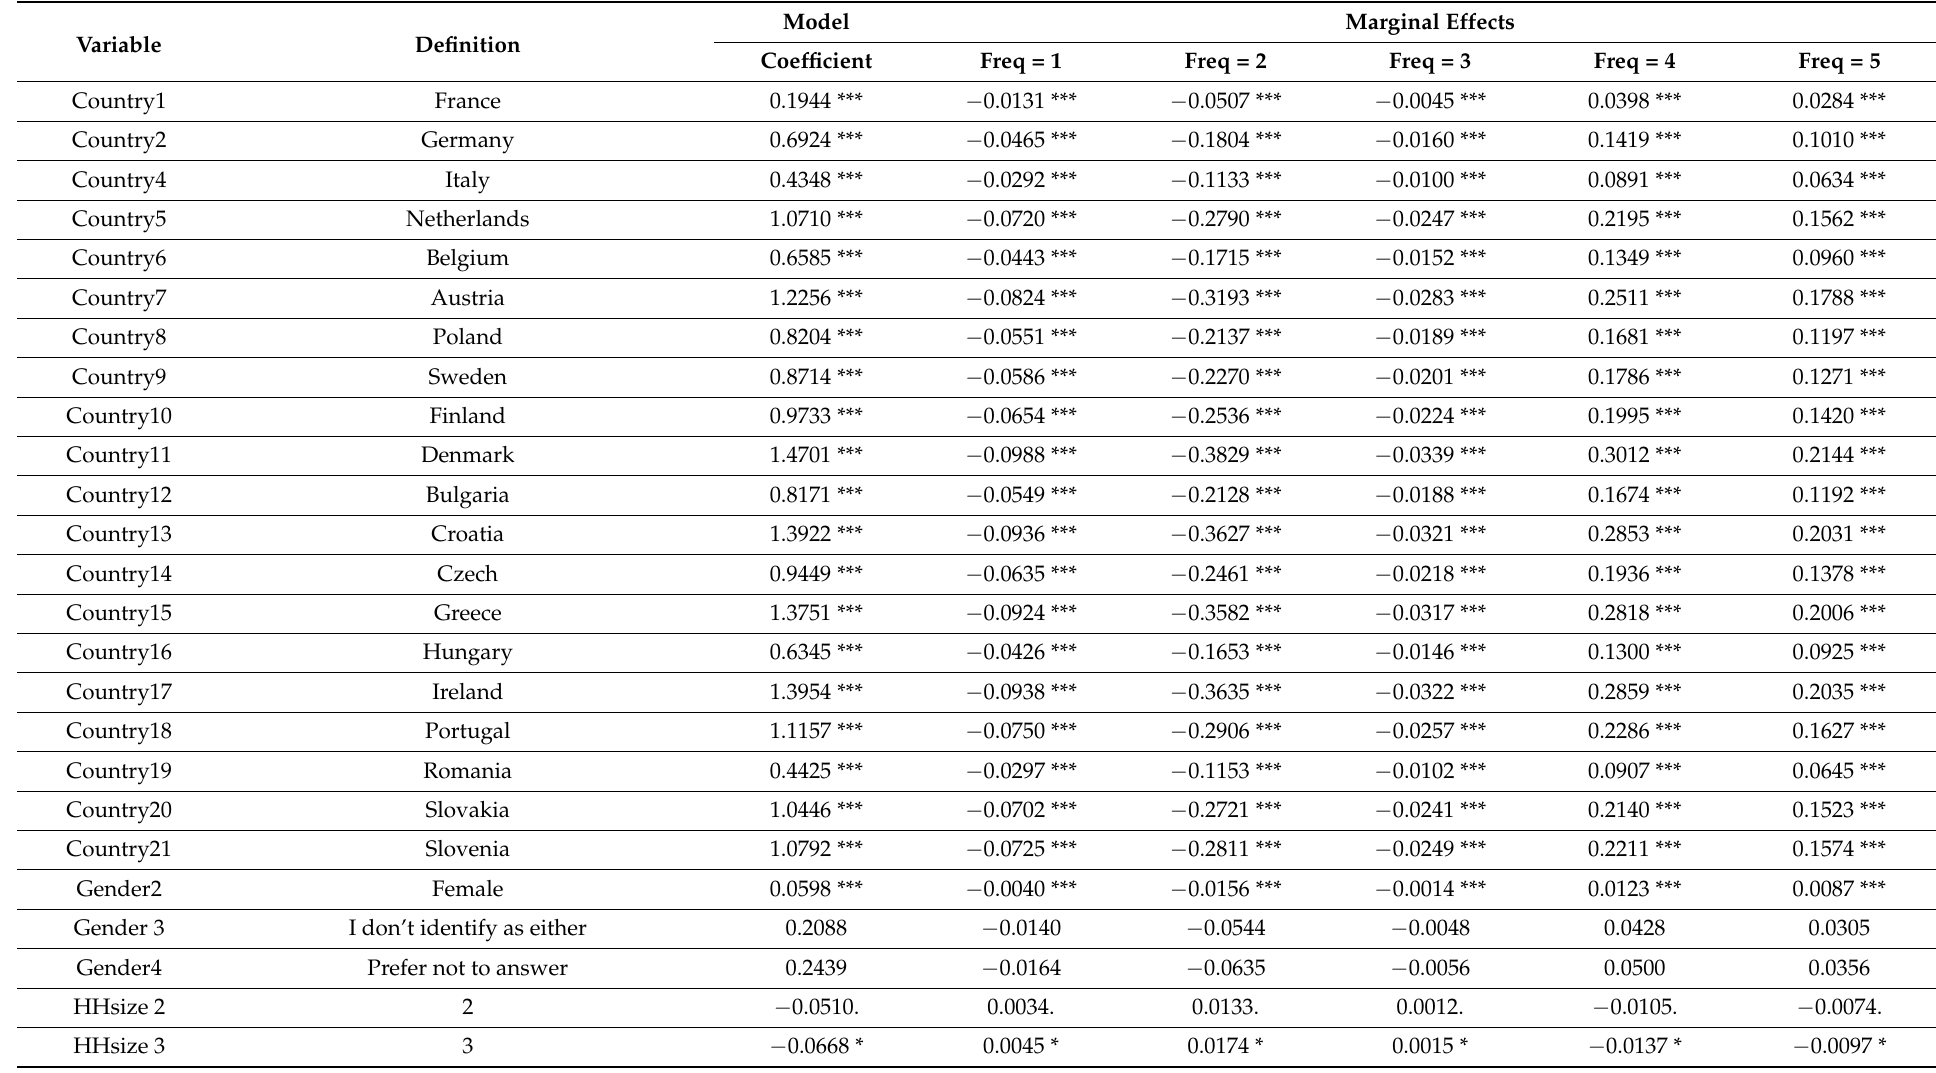
Table A3. Homoscedastic